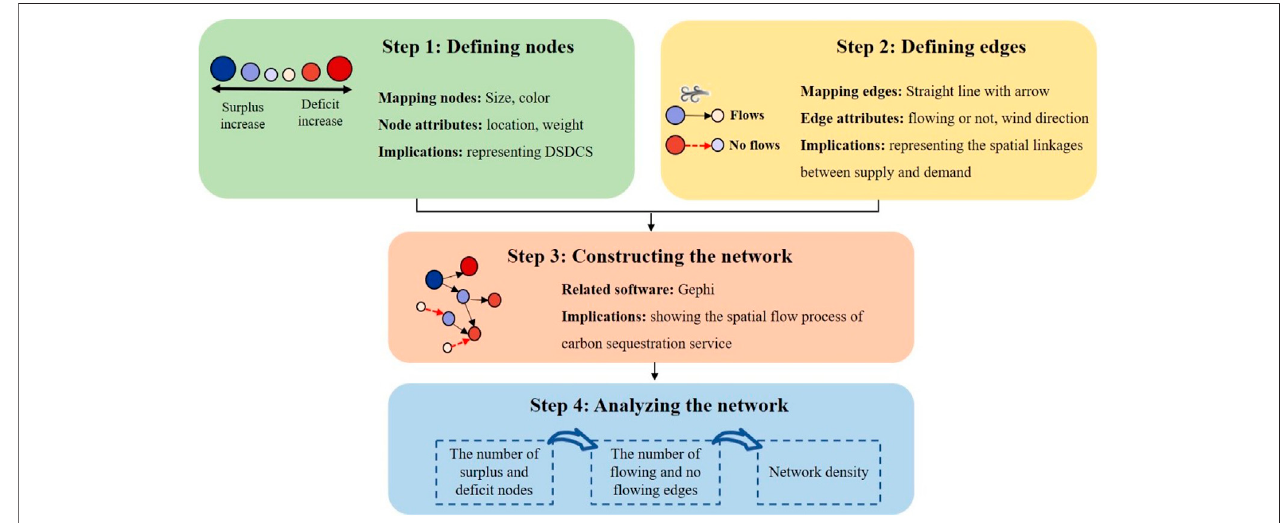
FIGURE 2 | Summary of the steps for mapping the service fl ow network.